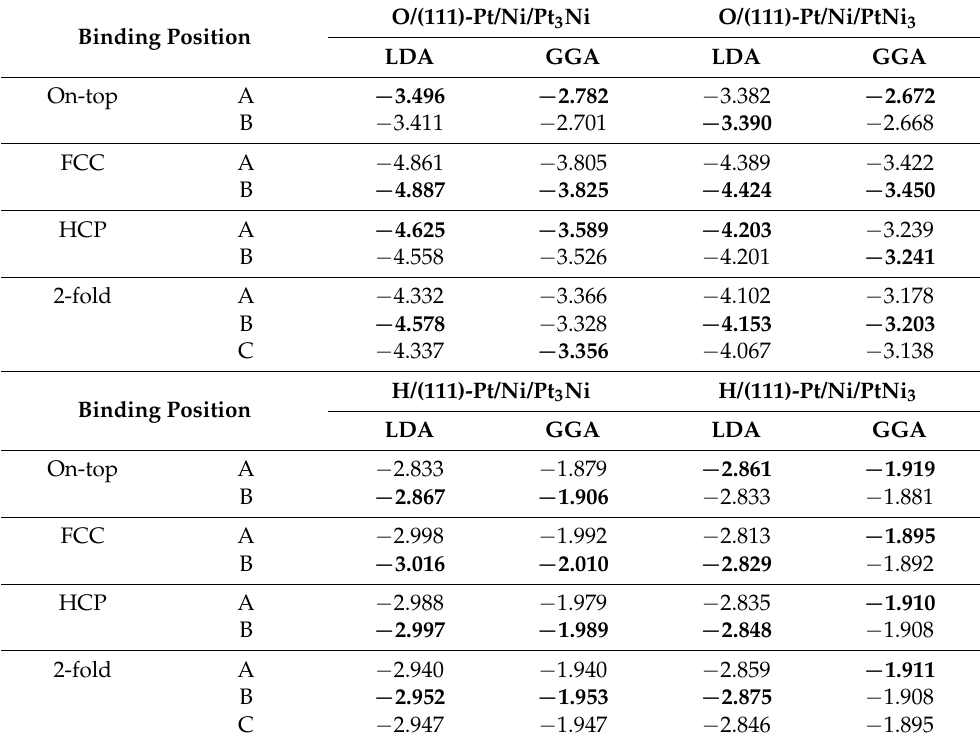
Table 5. Oxygen and hydrogen adsorption energies E ads on the high symmetry sites of the (111)- Pt/Ni/Pt 3 Ni and (111)-Pt/Ni/PtNi 3 surfaces. The binding positions are defined in Figure 14. The column subheadings (‘LDA’/‘GGA’) indicate the exchange-correlation functional used. The values shown in bold are the lowest energy for a particular type of binding position. All energies are in